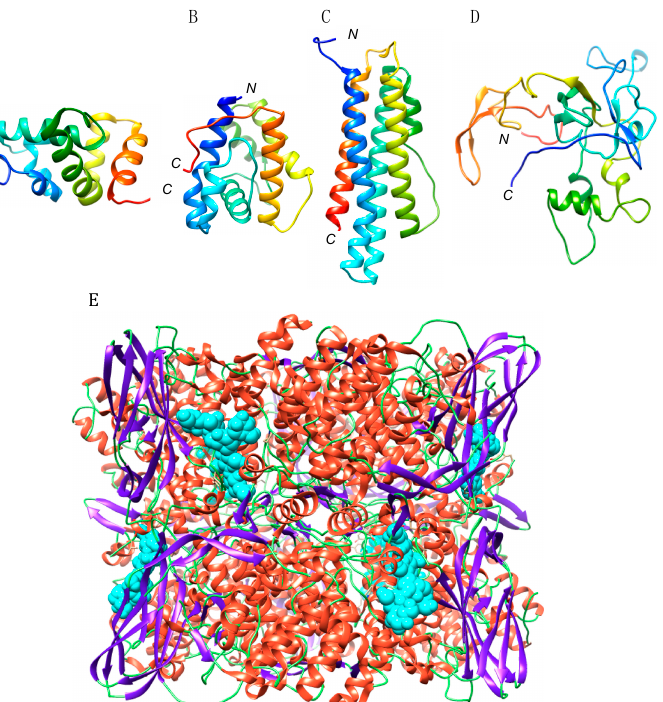
Figure 1. ( A–E ). Ribbon diagram of the three-dimensional structure/model of chemosensory protein ( A ), odorant binding protein ( B ), apolipophorin III ( C ), larval cuticle protein ( D ) and hexamerin ( E ), from Bombyx mori . N and C correspond to the N - and C -termini of the polypeptide chains. Fatty acids complexed to hexamerin are represented in spheres colored cyan.